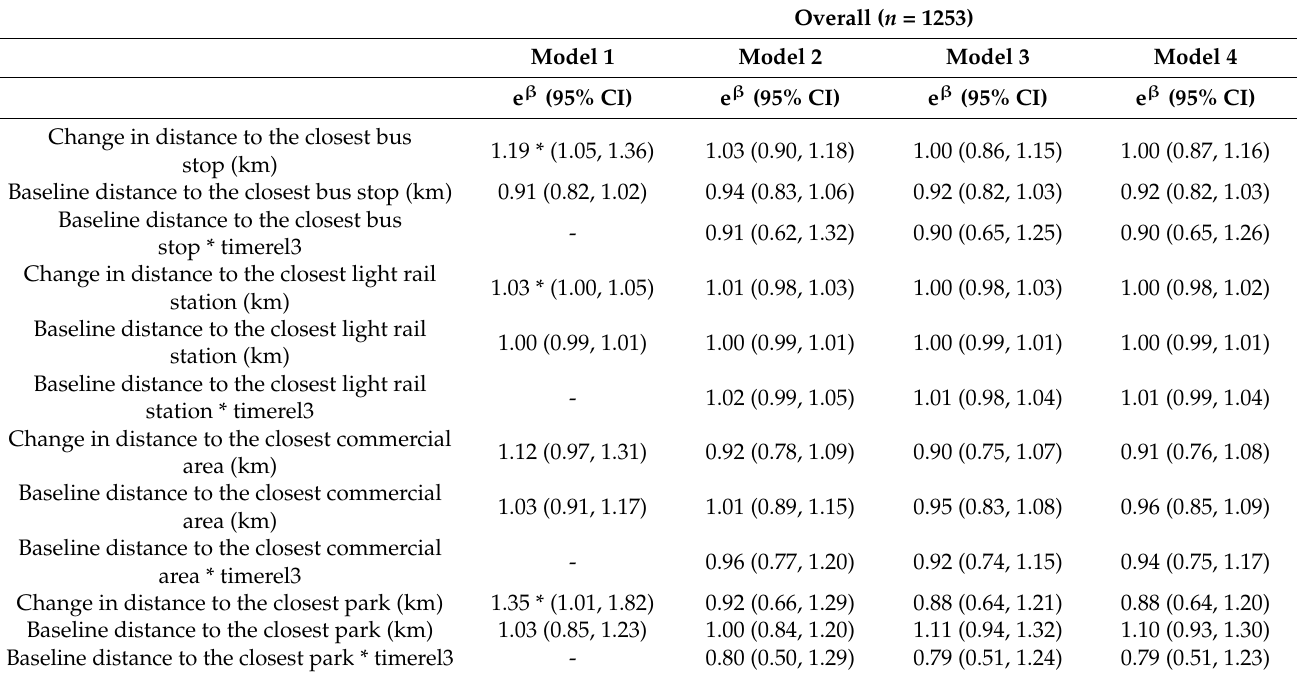
Table A5. Results from sensitivity analysis using Random Forest